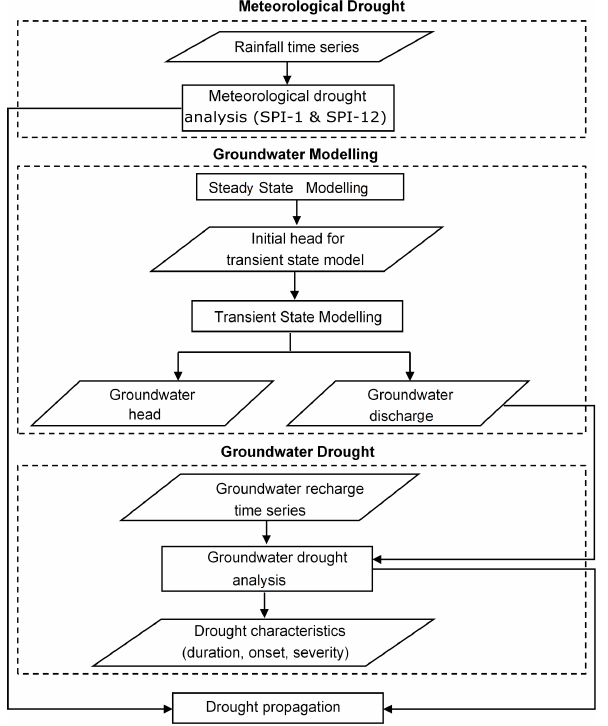
Figure 4. Conceptual framework of the study.